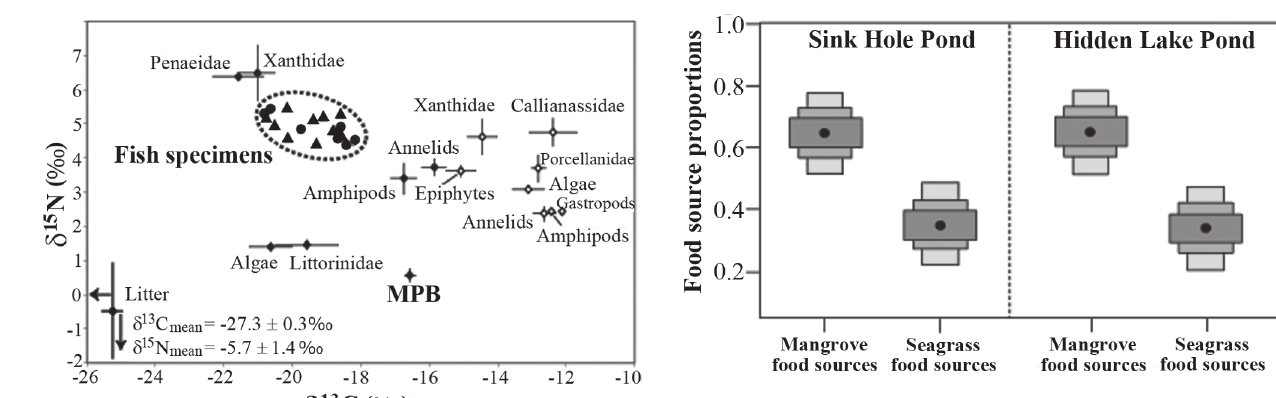
Fig. 4. Food source proportions (0-1) in the fish diets from Sink Hole and Hidden Lake ponds using SIAR mixing models. Prey items are grouped in mangrove and seagrass food sources. Means are represented by black dots and boxes indicate 50%, 75% and 95% Bayesian credible intervals for